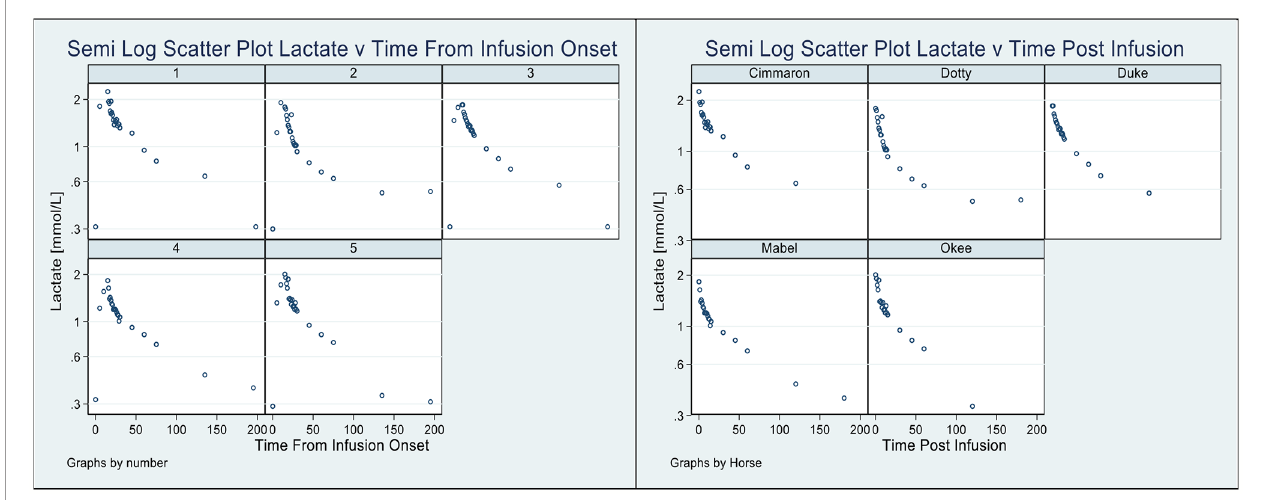
FIGURE 2 | Pattern of lactate disposition, by horse, from sample immediately prior to infusion to the fi nal observation (Left), and also shown (Right) the pattern of lactate disposition from the completion of the infusion to the fi nal